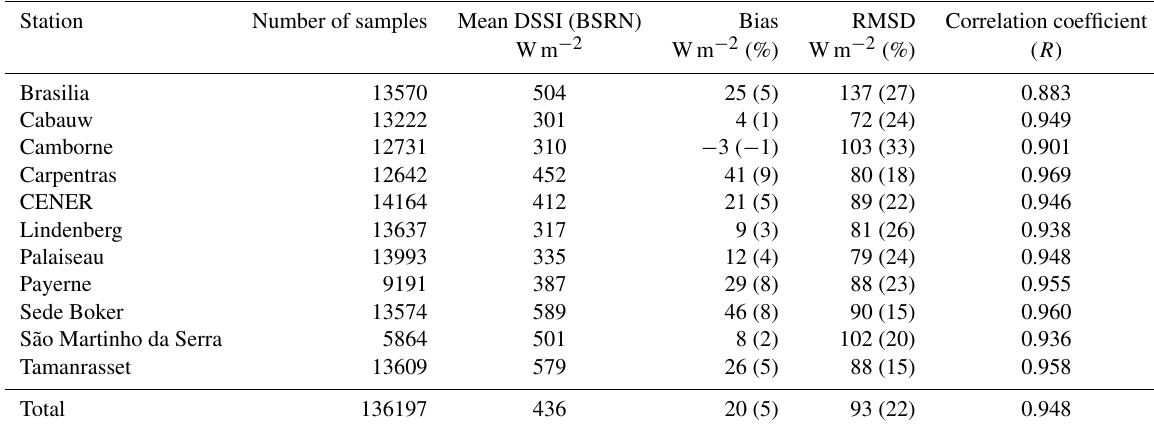
Table 4. Validation results for 15min means of all-sky DSSI for the year 2011. Results based on the imagery of the Meteosat-9/SEVIRI 0.6µm channel.